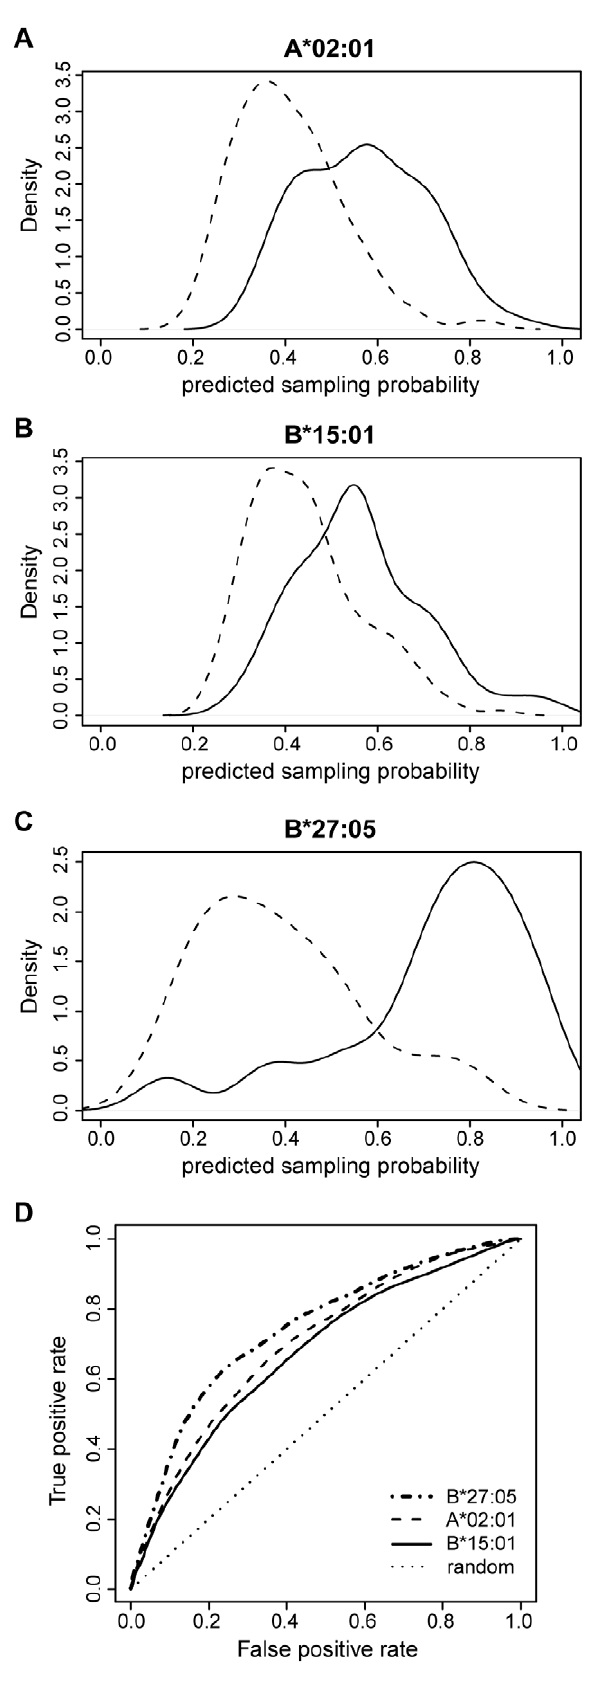
Figure 4. The regression model is able to distinguish sampled from non-sampled proteins. ( A – C ) Predicted sampling probability for A*02:01, B*15:01, and B*27:05 (best examples of 100 cross-validation runs per allele; solid line: sampled proteins; dashed line: non-sampled proteins). The sampling probability is calculated as f( z )=e z /(e z + 1) where z = c + c ab log10( ab ) + c pl pl + c hr hr with ab the protein abundance, pl the protein length, hr the predicted hit rate, and ( A ) c = 2 1.47, c ab =0.49, c pl = 0.0009, c hr = 17.7, p-value = 5e-15, ( B ) c = 2 1.42, c ab = 0.46, c pl =0.001, c hr =16.5, p-value=1e-14, and ( C ) c = 2 1.77, c ab =1.15, c pl =0.0005, c hr =47.4, p-value=1e-10. ( D ) Receiver operating charac- teristic (ROC) curve for A*02:01 (dashed), B*15:01 (solid), and B*27:05 (dash-dot) visualizing the performance of each of the regression models as a mean over 100 runs. The dotted line represents the ROC curve for random classification. Corresponding area under the curve (AUC): 0.70 for A*02:01, 0.68 for B*15:01, and 0.74 for